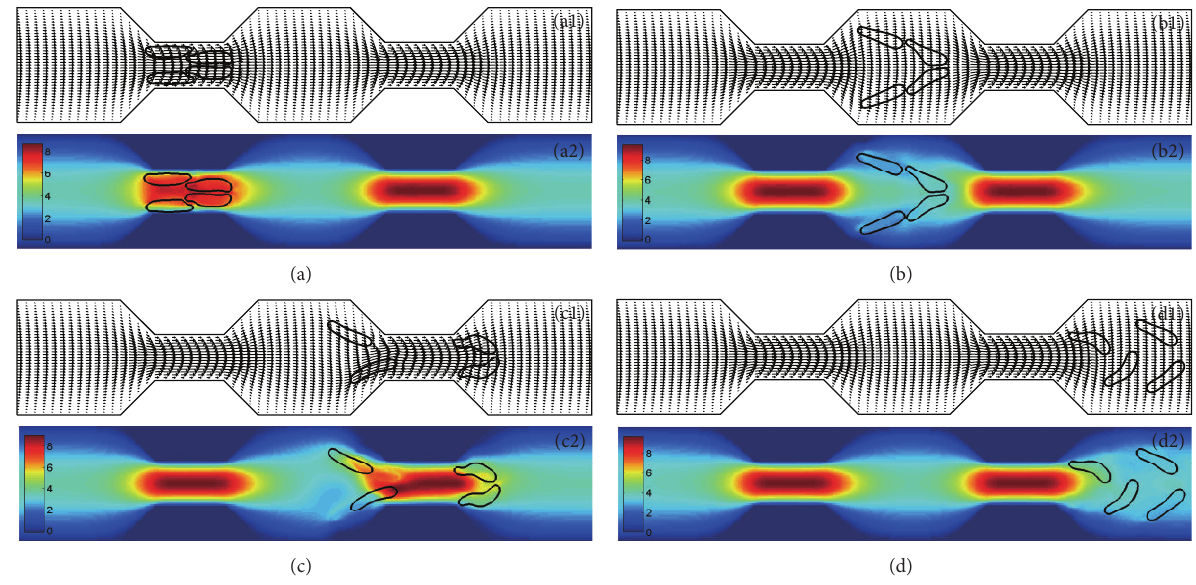
Figure 4: Motion and dissociation of a four-cell erythrocyte aggregate in a 8 𝜇 m stenotic channel at time instants (a) 𝑡 = 0.50 ms; (b) 𝑡 = 0.99 ms; (c) 𝑡 = 1.45 ms; and (d) 𝑡 = 1.90 ms. Velocity vectors (a1-d1) and axial velocity magnitude contours (cm/s) (a2-d2) are presented. The initial configuration for the aggregate is shown in Figure 1(c), and the aggregate is horizontally placed in the channel initially. The parameters used are 𝐷 𝑒 = 1.0 × 10 −2 𝜇 J/m 2 , 𝑘 𝑏 = 5.0 × 10 −13